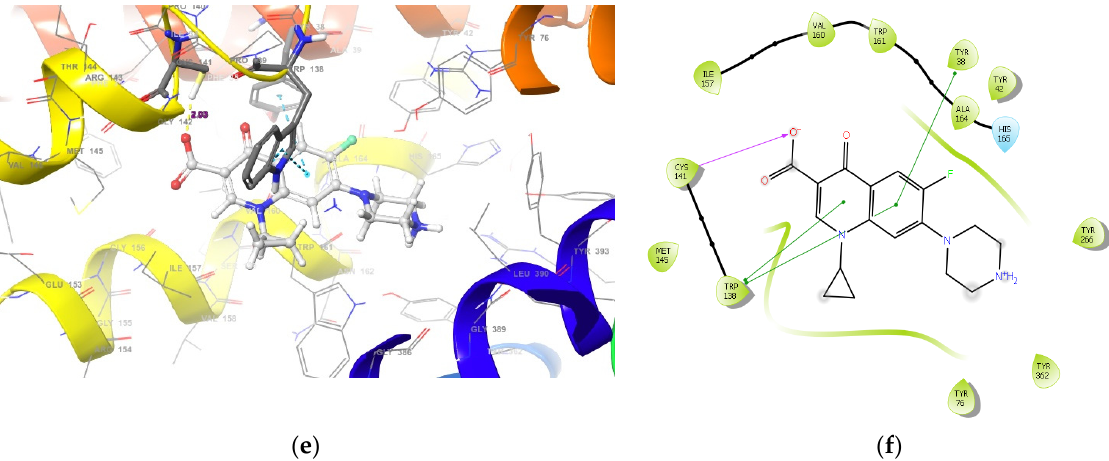
Figure 1. The binding mode of ( a ) sinapic acid ( c ) p-coumaric acid, and ( e ) ciprofloxacin in the active site cavity of NorA. The ligand interaction diagram of ( b ) sinapic acid, ( d ) p-coumaric acid, and ( f ) ciprofloxacin.